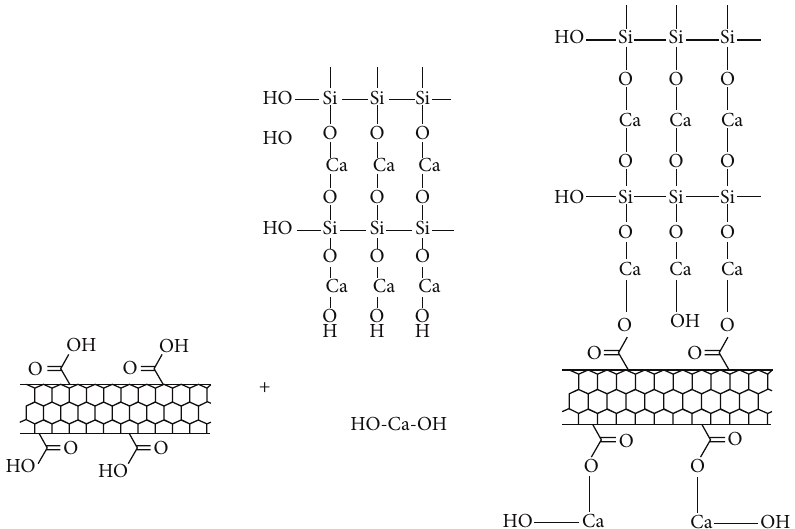
Figure 6: Reaction scheme between carboxylated nanotube and hydrated production of cement [66].